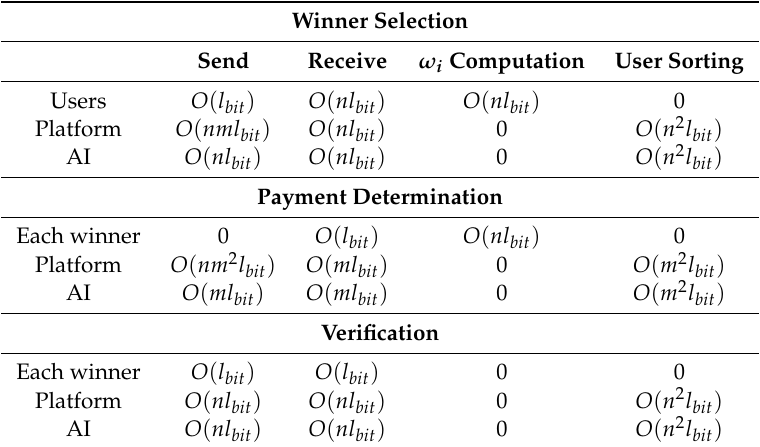
Table 2. Communication overhead of PVI-H.